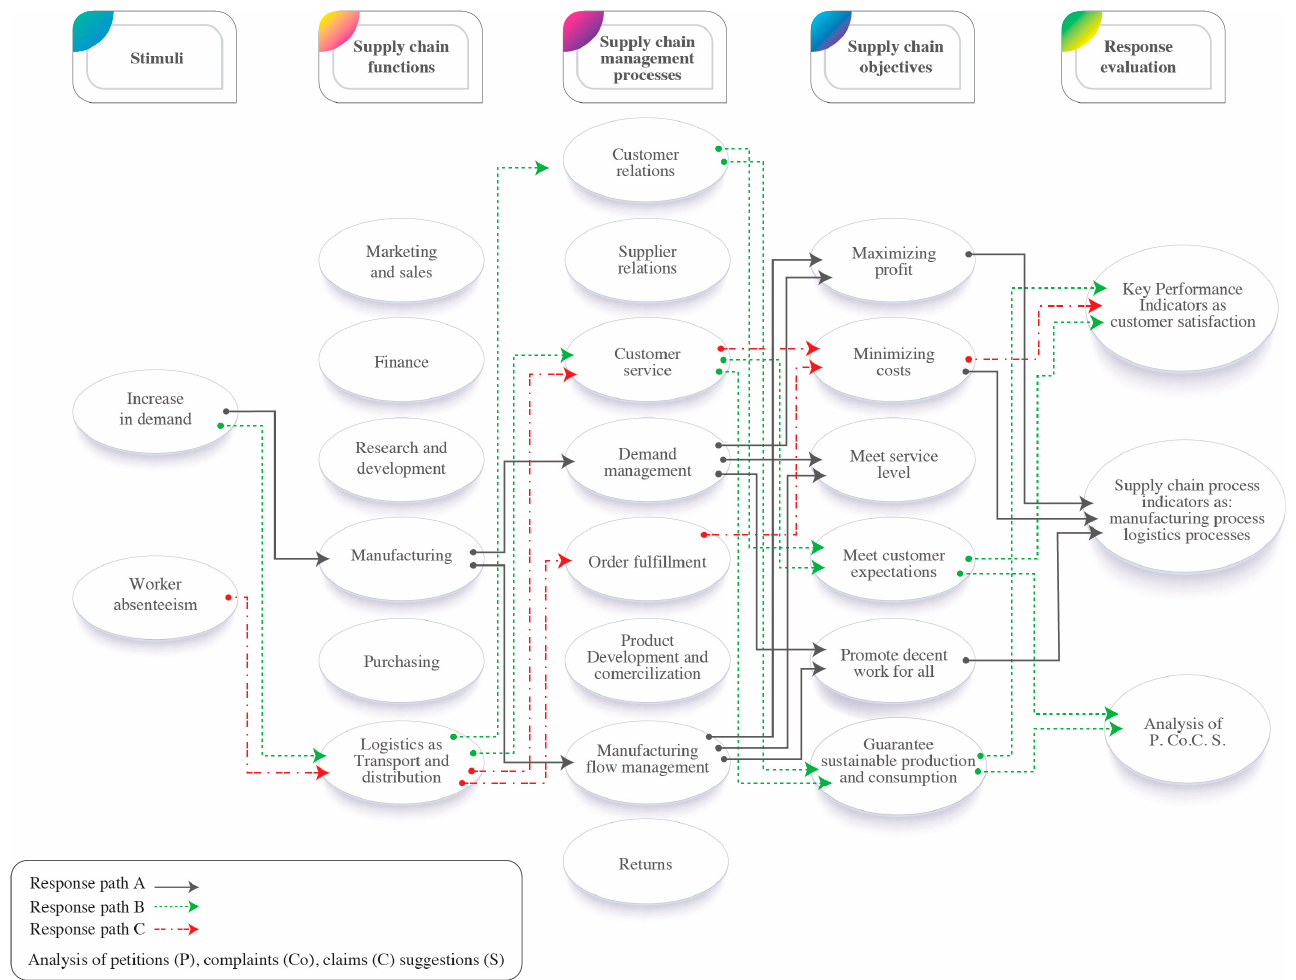
Figure 1. Supply chain response paths .